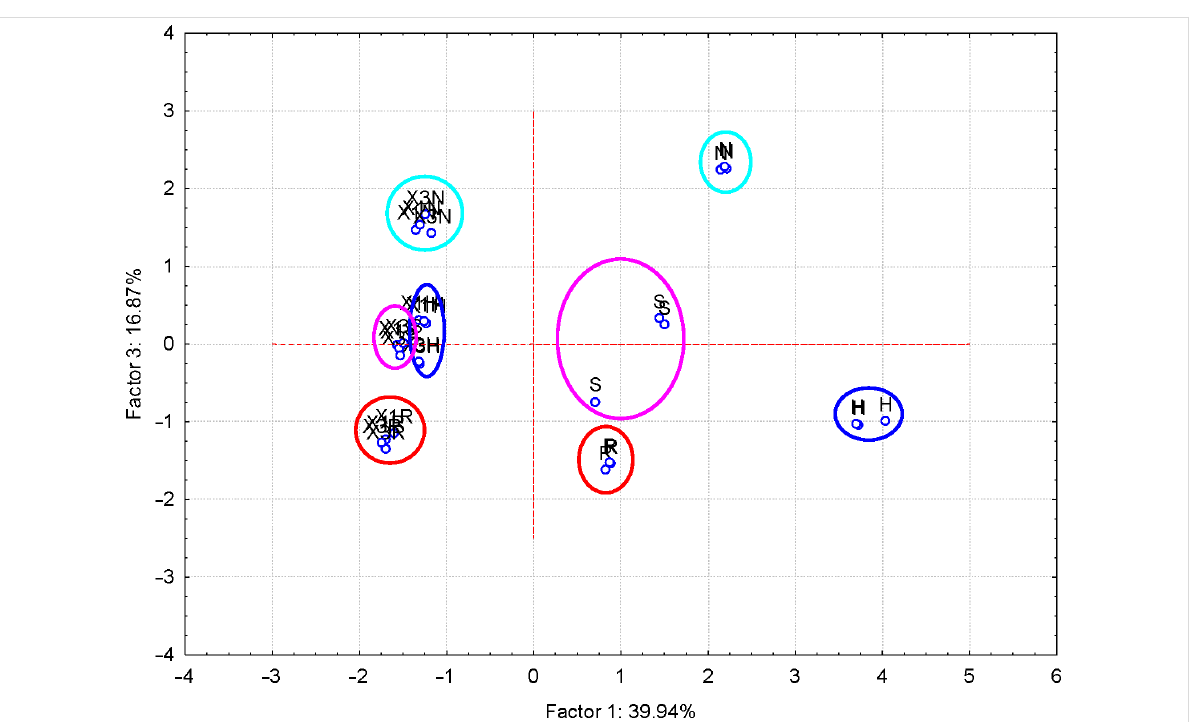
Figure 8: PC 3 versus PC 1 scores plot from the FTIR-PCA analysis of the β -CD/hazelnut oil/flavonoid ternary complexes (codes: “X1H/N/R/S” and “X3H/N/R/S” for the 1:1:1 and 3:1:1 ternary complexes with hesperidin/naringin/rutin/silymarin, respectively) and flavonoids (codes: “H” – hesperidin, “N” – naringin, “R” – rutin and “S” – silymarin); only wavenumbers of the FTIR bands were used as input